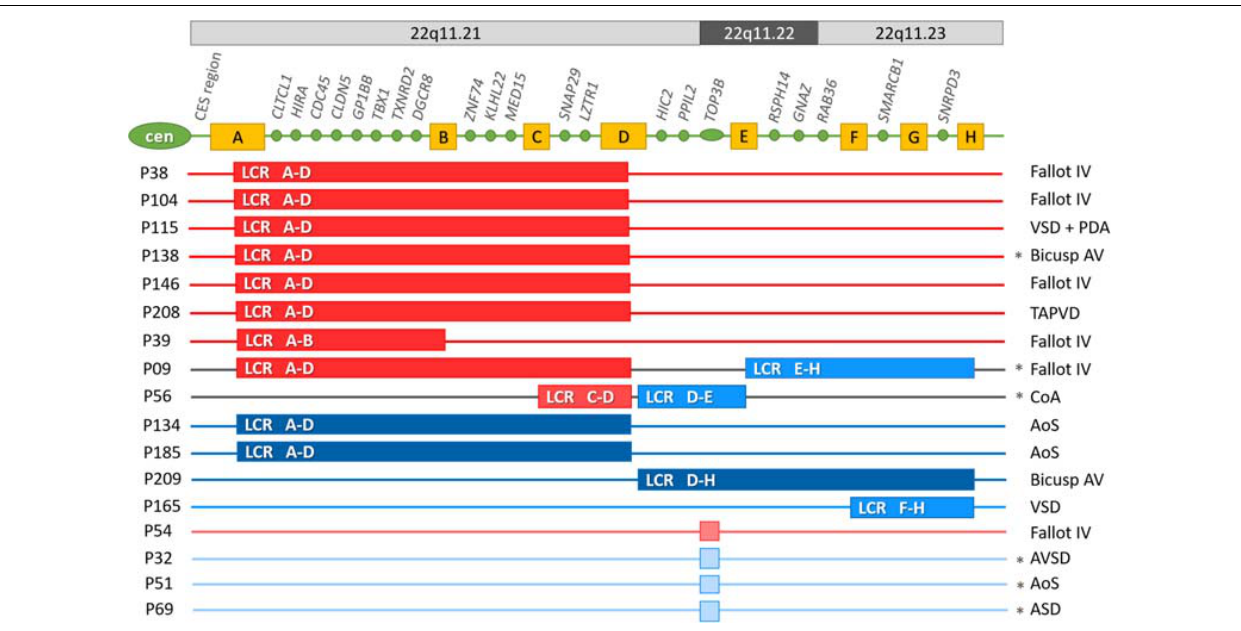
FIGURE 1 | Pathogenic variants, variants of uncertain significance and benign 22q11.2 copy number variations in the CHD cohort. Cen, centromere; CES, Cat eye syndrome region; A-H yellow boxes: low copy repeat regions in locus 22q11.2. Genes indicated between the LCR regions, are the ones that have corresponding probes in the P250-B2 DiGeorge SALSA MLPA Probemix; LCR: low copy repeat region. Dark red: pathogenic microdeletion; Dark blue: pathogenic microduplication; Middle red: microdeletion of uncertain significance; Middle blue: microduplication of uncertain significance; Light red: benign microdeletion; Light blue: benign microduplication. LCR A-D: the typical ∼ 2.5–3 Mb microdeletion in region 22q11.21; LCR A-B: ∼ 1.5 Mb proximal microdeletion in region 22q11.21; LCR C-D: ∼ 0.5 Mb central microdeletion in region 22q11.21; LCR D-E: ∼ 1.2 Mb central microduplication in region 22q11.21q11.22; LCR D-H: ∼ 3.1–3.5 Mb central-distal microduplication in region 22q11.21q23; LCR E-H: ∼ 1.55–2 Mb distal microduplication in region 22q11.22q11.23; LCR F-H: ∼ 1–1.2 Mb distal microduplication in region 22q11.23; Asterix denotes familial CNVs. AoS, congenital aorta stenosis; AVSD, atrioventricular septal defect; bicuspid AV: bicuspid